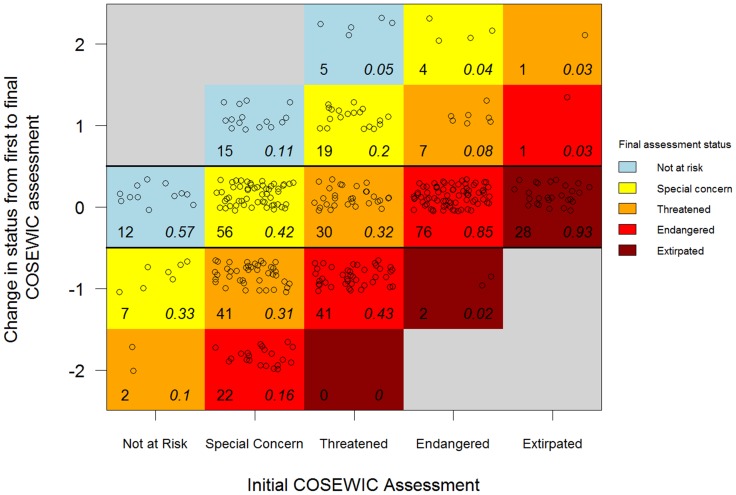
Trends in COSEWIC statuses for each species, grouped by initial assessments.Proportions are grouped by initial assessment status (column). Change from first to final assessment is indicated on the Y axis, and colours indicate the final assessment status. For example, of species that were initially assessed as threatened (third column), 19 of them (or a proportion of 0.2) improved by one status level (+1 on Y-axis), ultimately placing them into the special concern category (yellow).